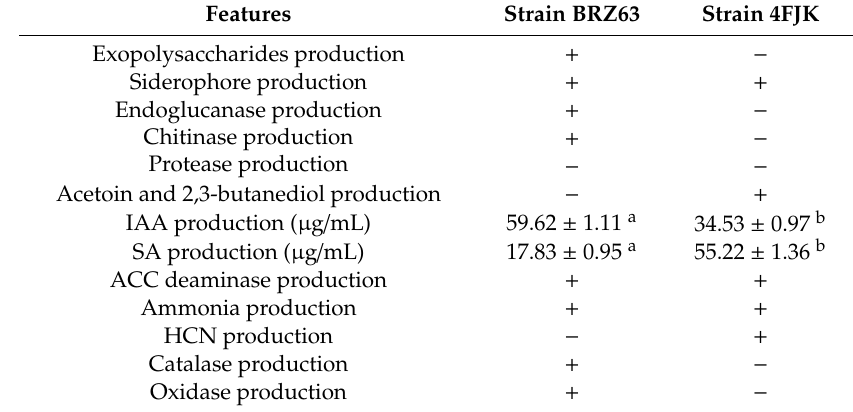
Table 1. Biochemical and physiological characteristics of endophytic P. fluorescens BRZ63. Features